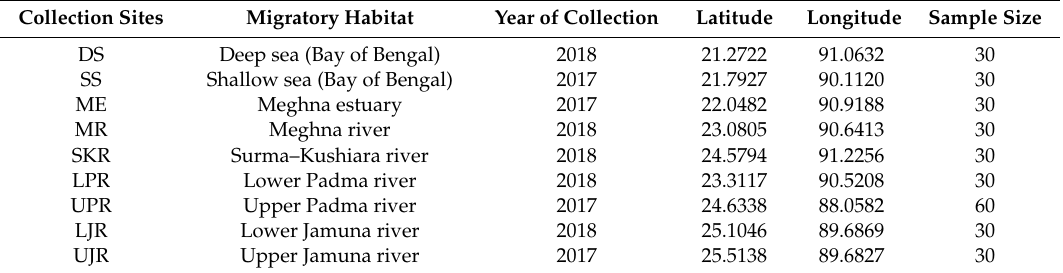
Table 1. Summary of the sampling information on Tenualosa ilisha for NextRAD